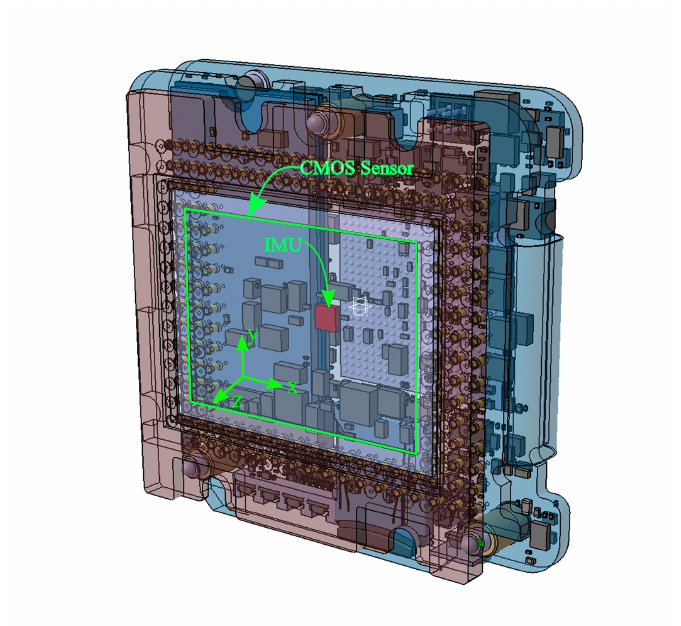
Figure 3. The IMU and the CMOS sensor inside the IGN